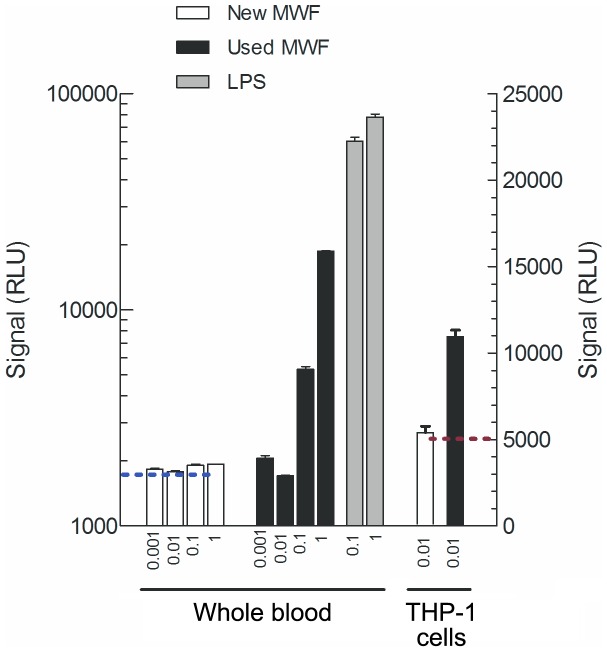
TNF-α production from whole blood or THP-1 cells after stimulation with new or used metalworking fluid (MWF) measured with ELISA and expressed as relative luminescence units (RLU).Whole blood sample was incubated during 4% to 1% of new and used MWF or LPS (positive control) diluted in 0.9% NaCl. THP-1 cells were incubated during 24 hours with 0.01% new or used MWF in culture medium. For details see Materials and method. Each bar represents mean ± SD of two experiments.